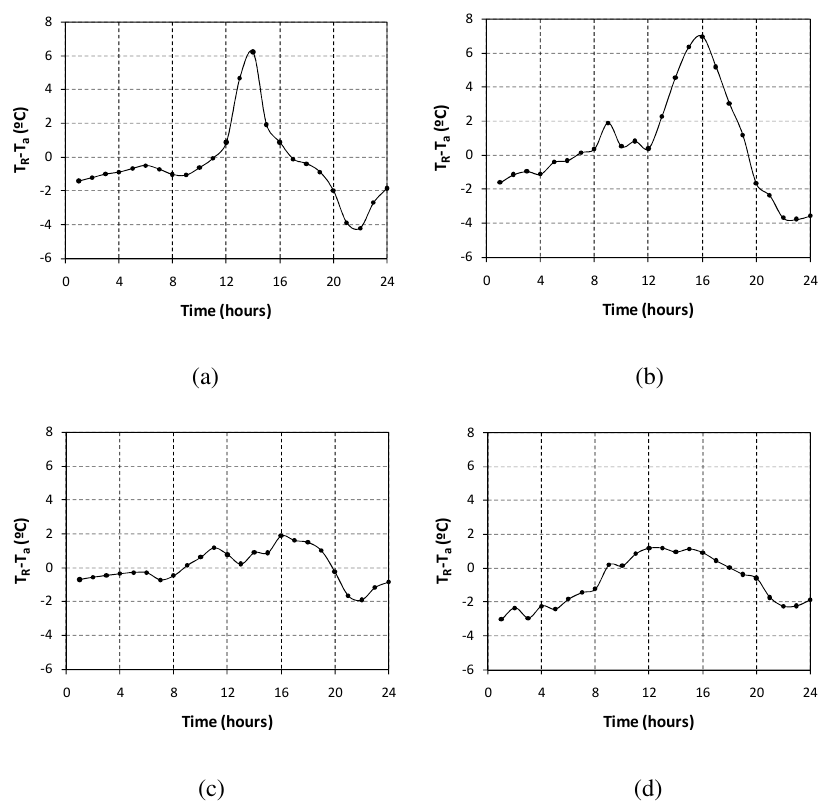
Figure 3. Diurnal evolution of the gradient between sorghum radiometric temperature 5 Fig. 3. Diurnal evolution of the gradient between sorghum radiometric temperature and air temperature: (a) DOY 184, (b) DOY 185, (c) and air temperature: (a) DOY 184, (b) DOY 185, (c) DOY 229, (d) DOY 236. 6 DOY 229, (d) DOY